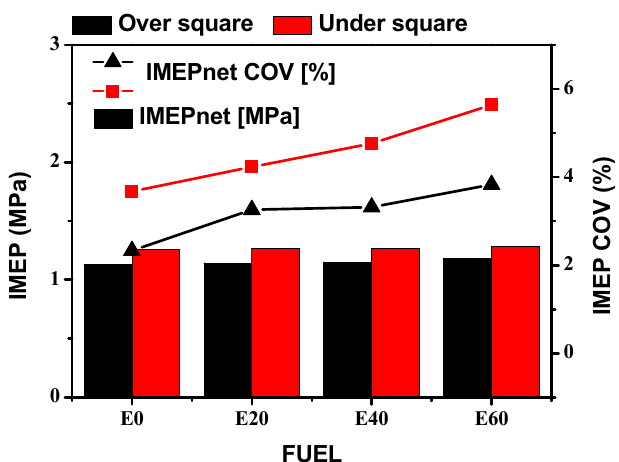
Figure 11. Indicated mean effective pressure (IMEP) and coefficient of variation (COV) for over- and under-square engine and ethanol blending ratio.